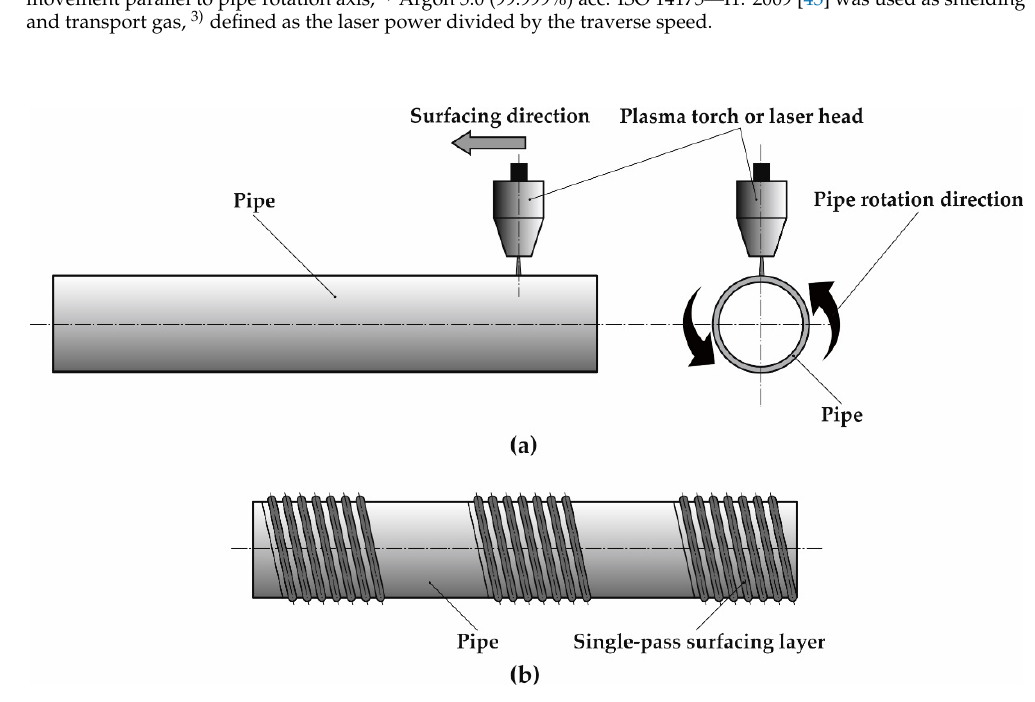
Table 7. Processing parameters of robotic laser powder surfacing of Inconel 625 superalloy layer on the outer surface of the 16Mo3 steel pipe.